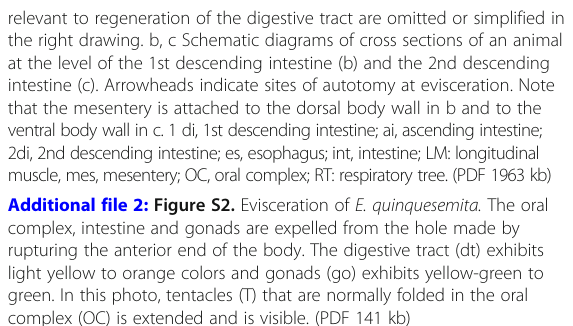
Additional file 2: Figure S2. Evisceration of E. quinquesemita. The oral complex, intestine and gonads are expelled from the hole made by rupturing the anterior end of the body. The digestive tract (dt) exhibits light yellow to orange colors and gonads (go) exhibits yellow-green to green. In this photo, tentacles (T) that are normally folded in the oral complex (OC) is extended and is visible. (PDF 141